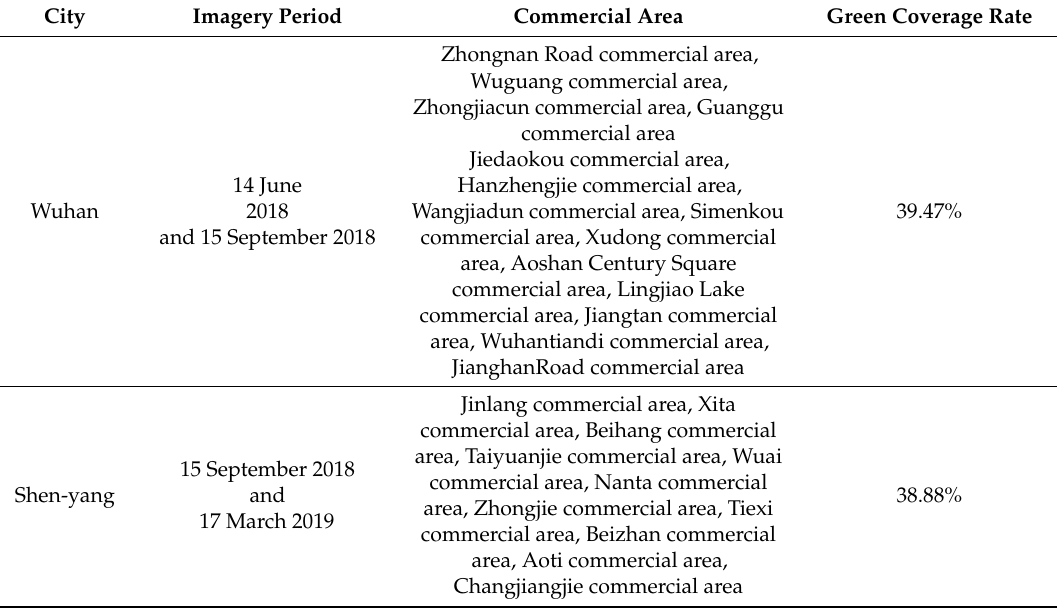
Table 2. Commercial areas and green coverage rate of the two